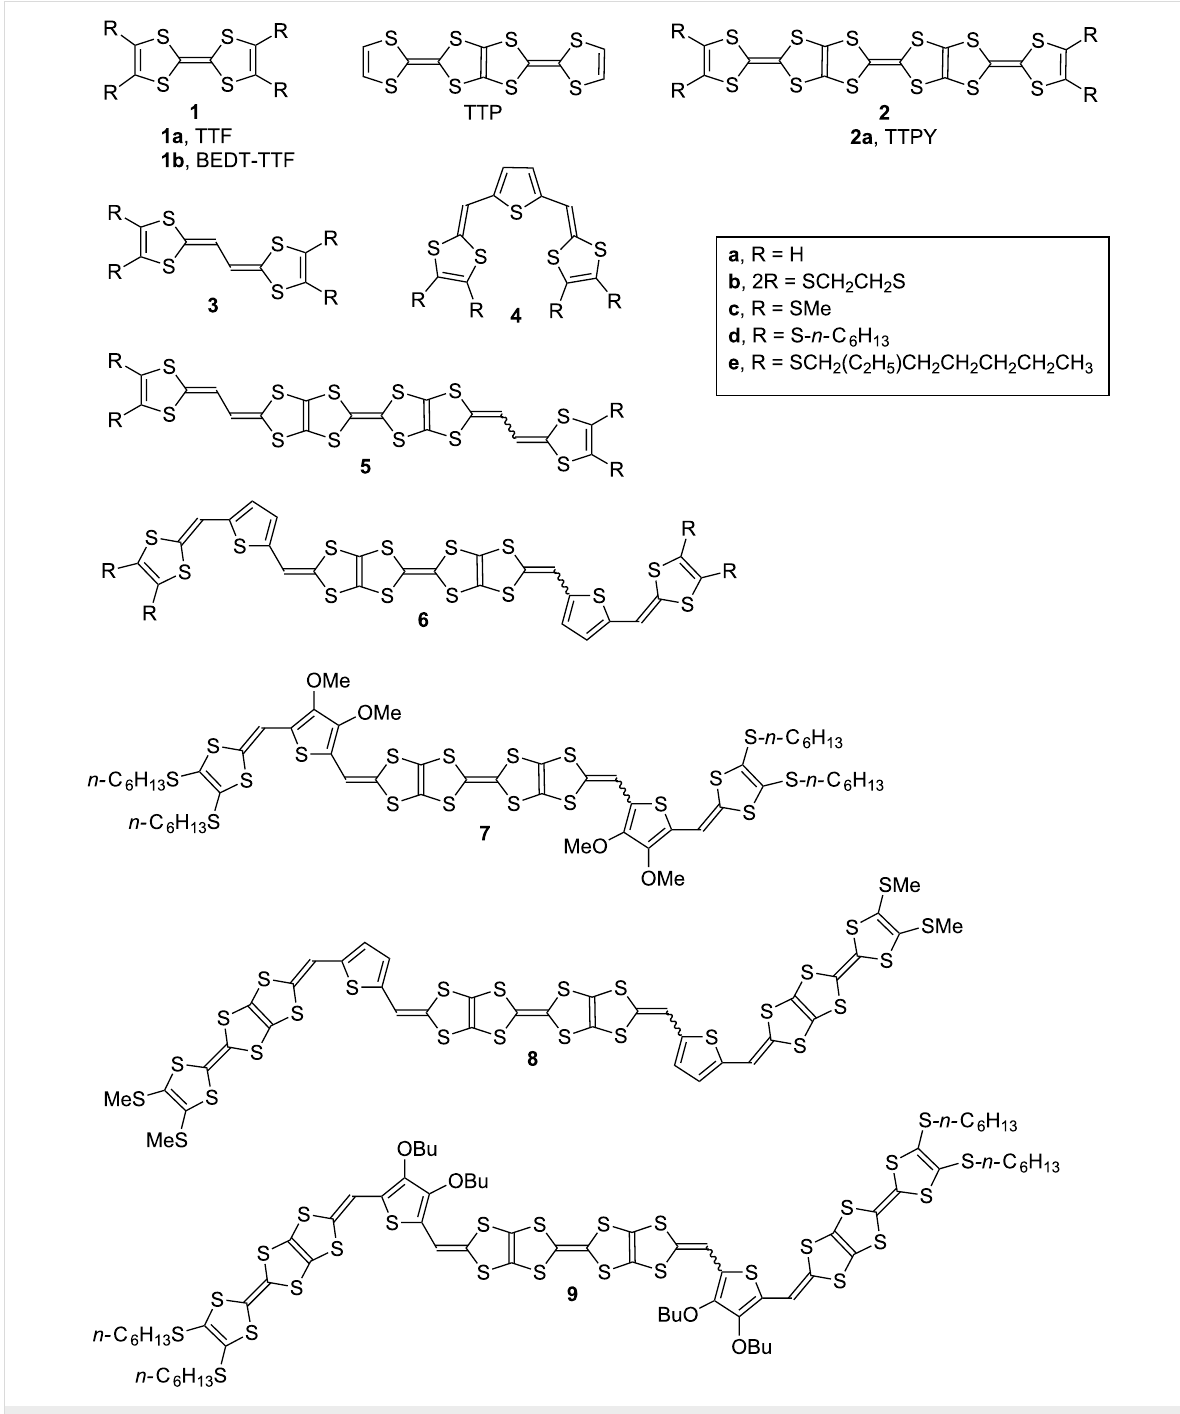
Figure 1: Chemical structures of 1 – 9 and TTP.